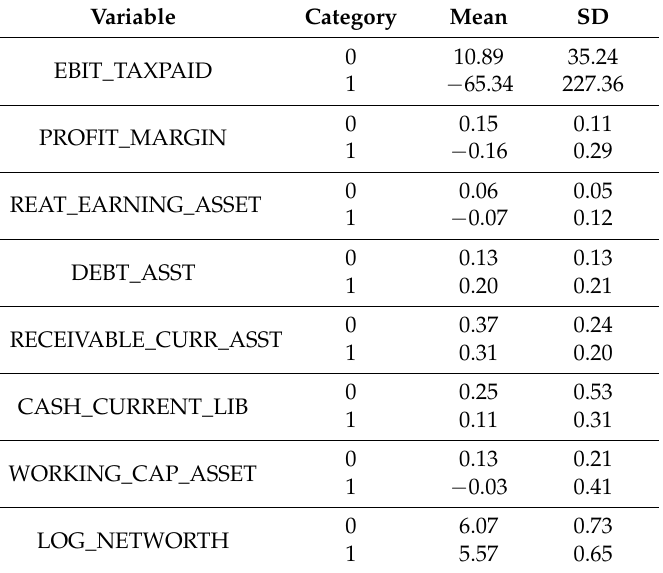
Table 2. Descriptive Statistic—Entire Sample.